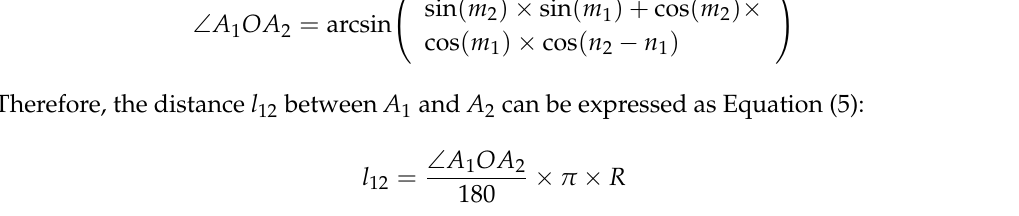
Figure 10. Example of the spherical distance-calculation method.